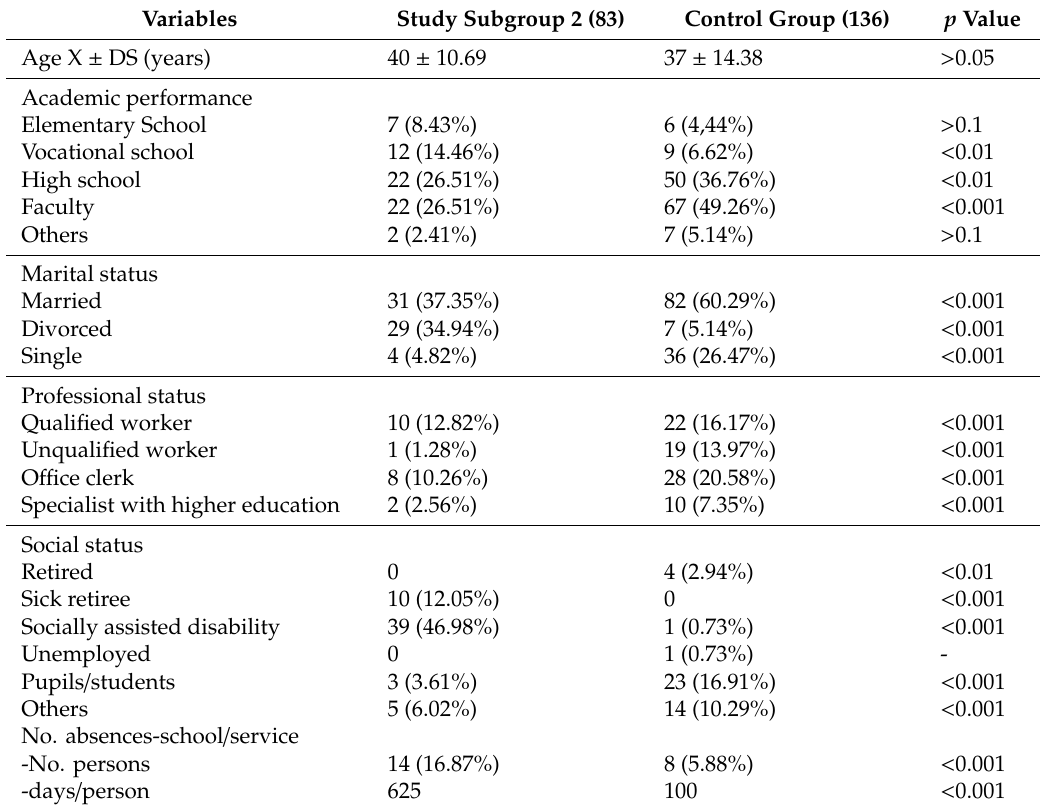
Table 2. Social impact of hemophilia on